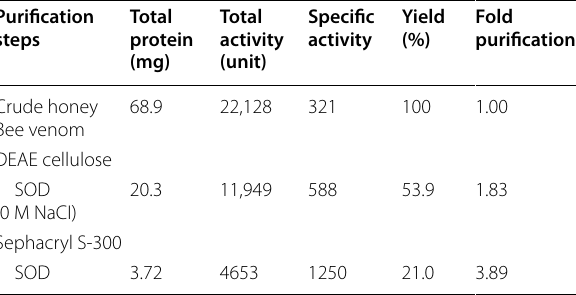
Table 1 A Typical purification scheme of BVSOD